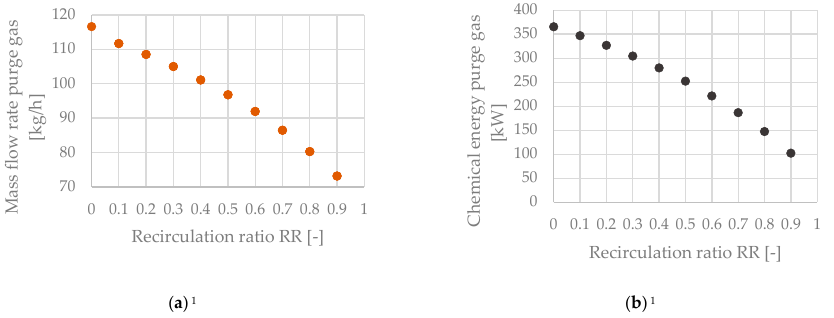
Figure 12. Purge gas stream for the configuration without a tail gas reformer—( a ) mass flow rate as a function of the recirculation ratio, ( b ) chemical energy as a function of the recirculation ratio. 1 No purge gas stream occurs for the process route that includes a tail gas reformer.